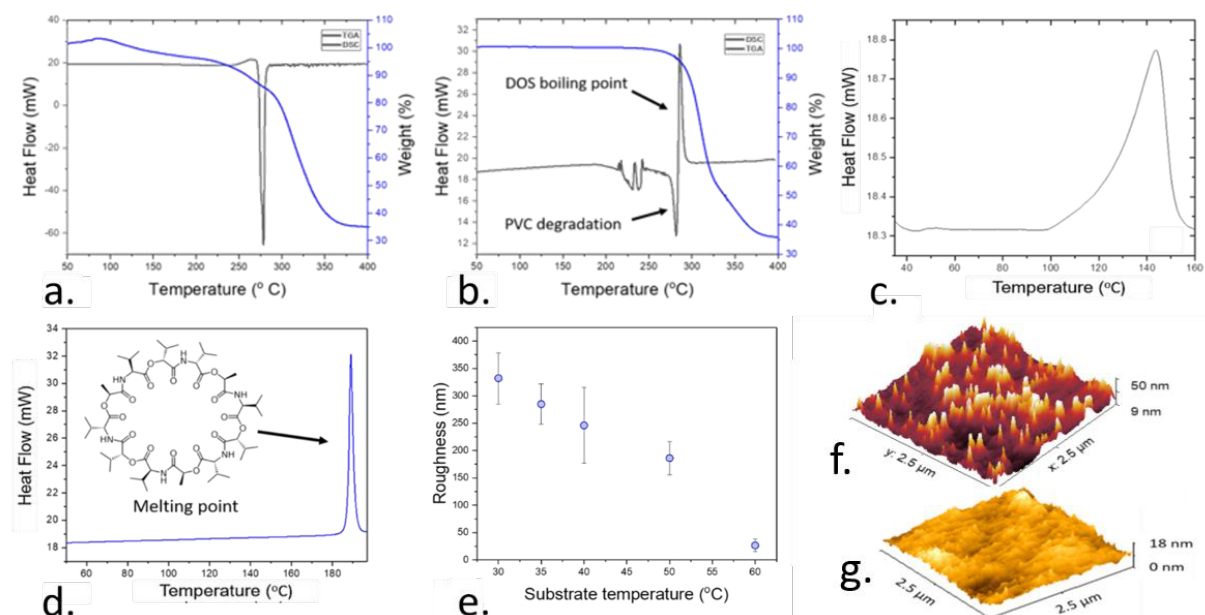
Figure 2. Results obtained during the thermal characterization of the sensitive ion films. ( a ). Combined thermogravimetric analysis (TGA, blue) and differential scanning calorimetry (DSC, black) plot of a pure PVC film, showing the thermal degradation of this polymer at high temperatures. ( b ). Combined TGA (blue) and DSC (black) plot of a plasticized polyvinyl chloride (PVC) film containing 2-(ethylhexyl) sebacate (DOS) as plasticizer. The previously observed degradation peak can be observed alongside an endothermal peak due to the boiling of DSC. ( c ). DSC plot of pure valinomycin, where the melting point reported at 190 ◦ C can be observed. ( d ). DSC characterization of the valinomycin embedded inside a plasticized high molecular weight PVC film, showing a displacement on the endothermal peak at 140 ◦ C. ( e ). Changes in the roughness of the sensing films as a function of the employed substrate temperature during the AACD process, showing an optimal temperature at 60 ◦ C. ( f ). Atomic force microscopy (AFM) of a plasticized PVC film deposited under non-optimal conditions (70 ◦ C) ( g ). AFM visualization of the surface of the sensing films deposited at 60 ◦ C, showing the low film